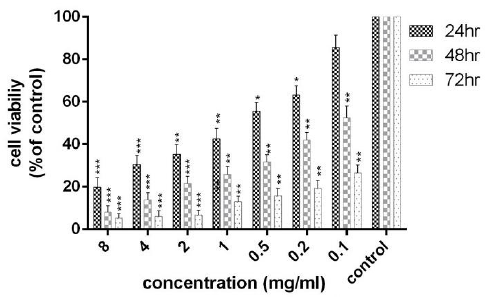
Fig. 3. Cytotoxicity effect of different concentrations of the extract on T47D cells after 24h,48h,72h (n=4, p<0.01**, p<0.01**, p<0.05*).